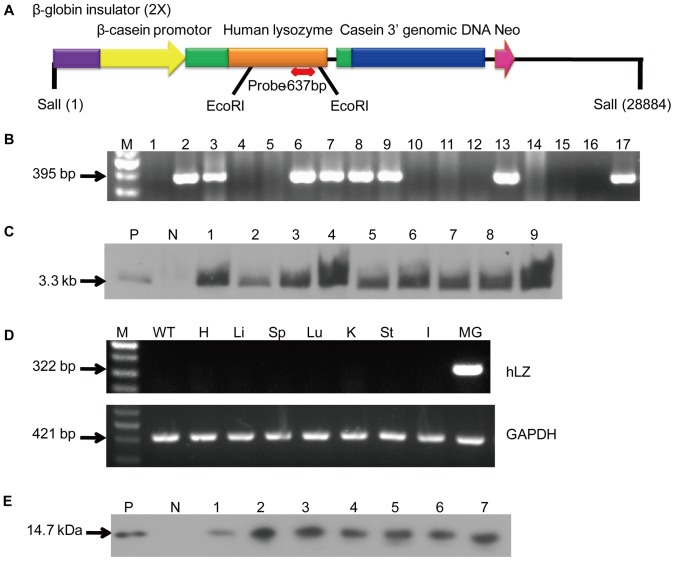
Generation and molecular characterization of transgenic pigs.(A) A schematic of pBC2-HLY-NEOR. The lower bars indicate the lengths of the PCR products and the primer pairs used for DIG-labeling of the probes to screen transgenic pigs. Globin insulator (2X), two copies of chicken β-globin insulator; β-casein promoter, goat β-casein promoter; human lysozyme, hLZ coding region; casein 3′ genomic DNA, goat β-casein 3′ genomic region. (B) PCR analysis of transgenic pigs. M, 1-kb DNA ladder; lanes 1–13, genomic DNA from transgenic pigs in the following order: 0201, 0203, 0205, 0207, 0301, 0303, 0305, 0307, 0309, 0311, 0313, 0315, and 0317; lanes 14–16, genomic DNA from three non-transgenic pigs; P, a positive control vector. (C) Southern blot identification of transgenic pigs. The bands were hybridized to a 637-bp specific probe that is complementary to a fragment of the hLZ gene. P, plasmid vectors as the positive control; N, genomic DNA from a non-transgenic pig; lanes 1–2, genomic DNA from F0 transgenic pigs 0303 and 0309; lanes 3–9, genomic DNA from F1 transgenic pigs in the following order: 0302, 0402, 0906, 1708, 1916, 0504, and 1504. (D) RT-PCR analysis of transgenic pigs. The 322-bp fragments represent the RT-PCR products of rhLZ and the 421-bp fragments represent the RT-PCR products of GAPDH. M, 1-kb DNA ladder; WT, wild-type pig mammary gland; H, transgenic pig heart; Li, liver; Sp, spleen; Lu, lung; K, kidney; St, stomach; I, intestine; and MG, mammary gland. (E) Western blot analysis of transgenic pigs. The milk samples collected on lactation day 1 were separated by SDS-PAGE and hybridized with anti-hLZ. P, commercial hLZ as a positive control (200 ng); N, non-transgenic milk; lanes 1–7, diluted milk from transgenic pigs (1∶3, 3 µL) in the following order: 0302, 0402, 0404, 0906, 1708, 1914, and 1916.